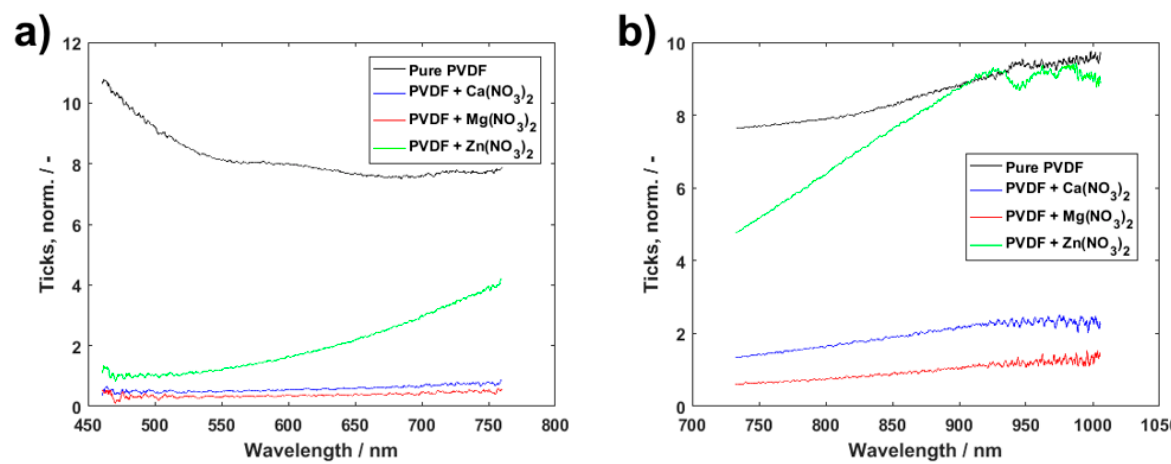
Figure 10. Transmittance spectra of pure PVDF fibers and those with Ca(NO 3 ) 2 , Mg(NO 3 ) 2 and Zn(NO 3 ) 2 in visual ( a ) and near-infrared ( b ) range. Table 1. Average, median and standard deviations for hydrophobicity measurement of pure